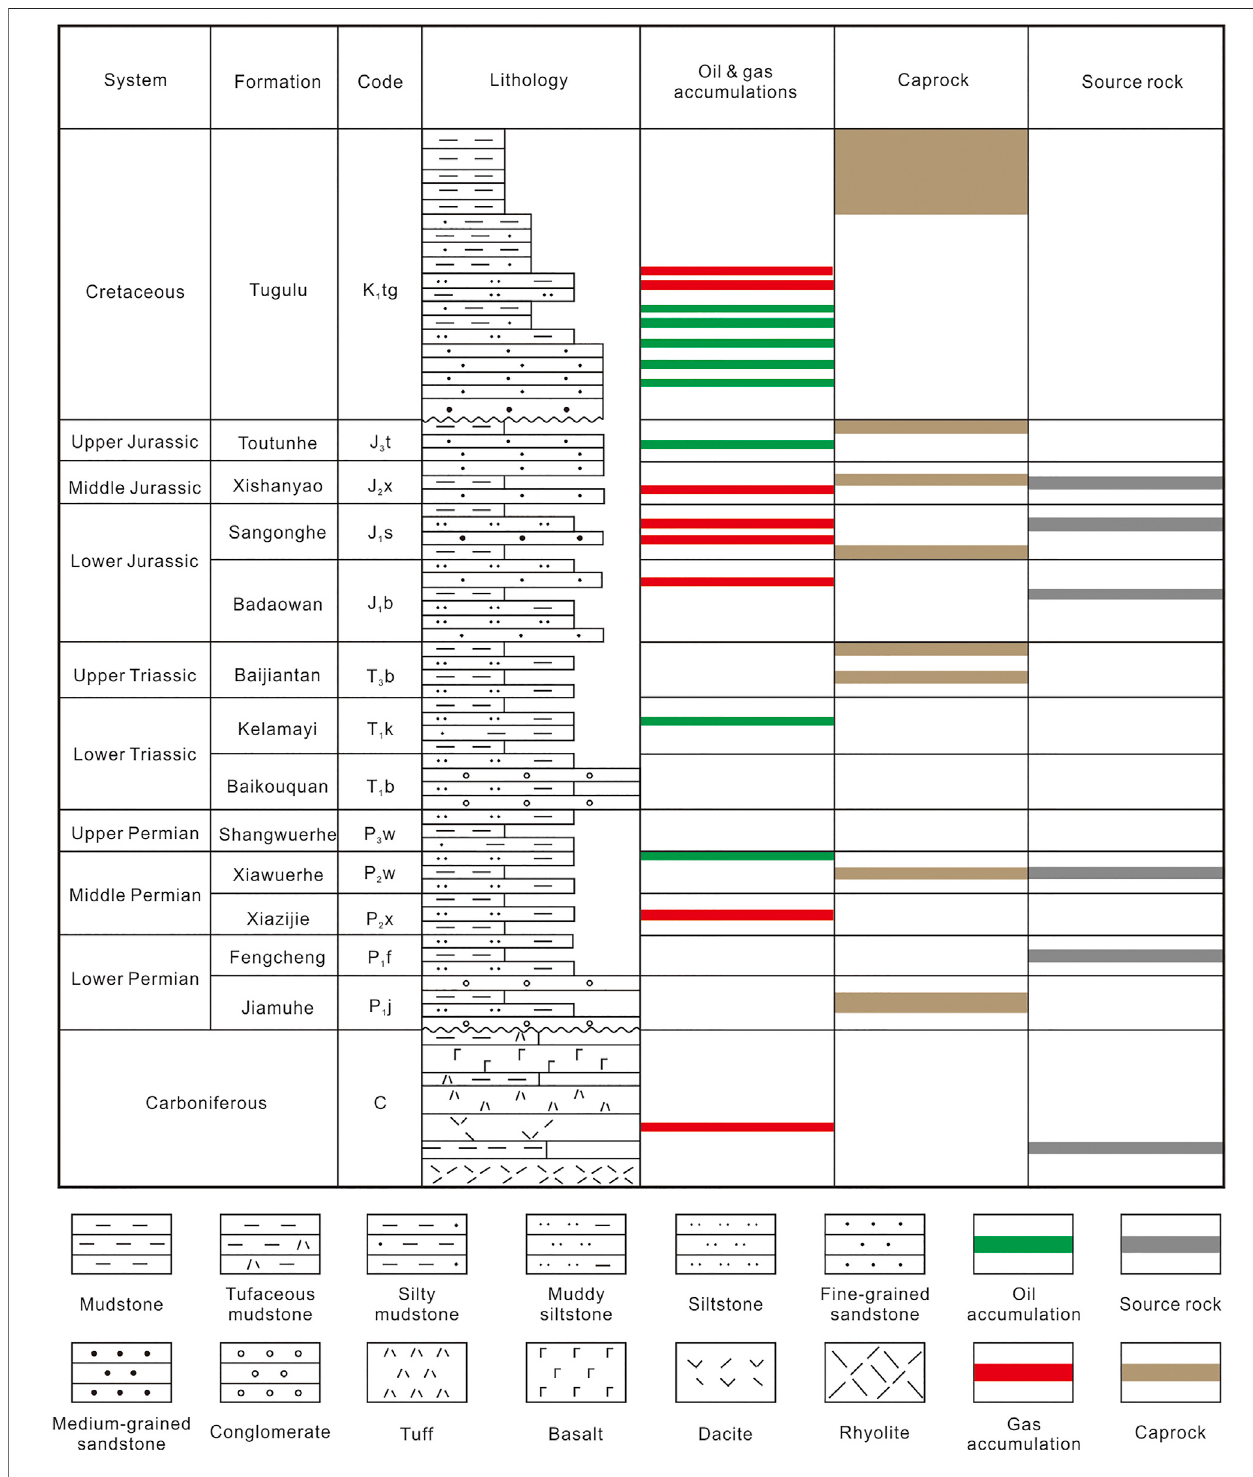
FIGURE 2 | Stratigraphic column in the hinterland of Junggar Basin.